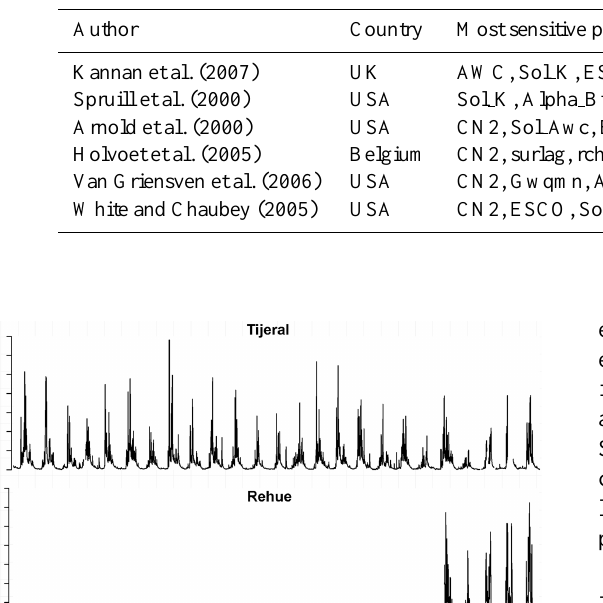
Table 7. Sensitive parameters obtained in the referred studies.